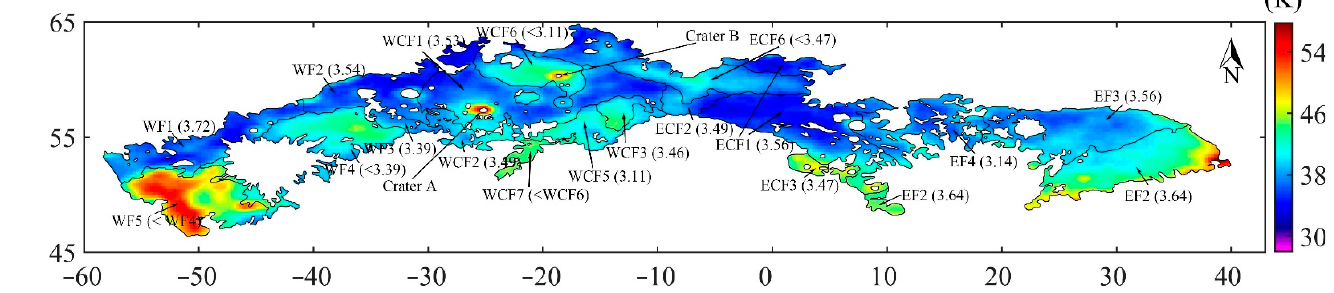
Figure 12. New geologic sketch of basaltic units in Mare Frigoris (equidistant cylindrical projection). The numbers after the unit names represent the ages in Ga. The base map is the TBD at 37 GHz.